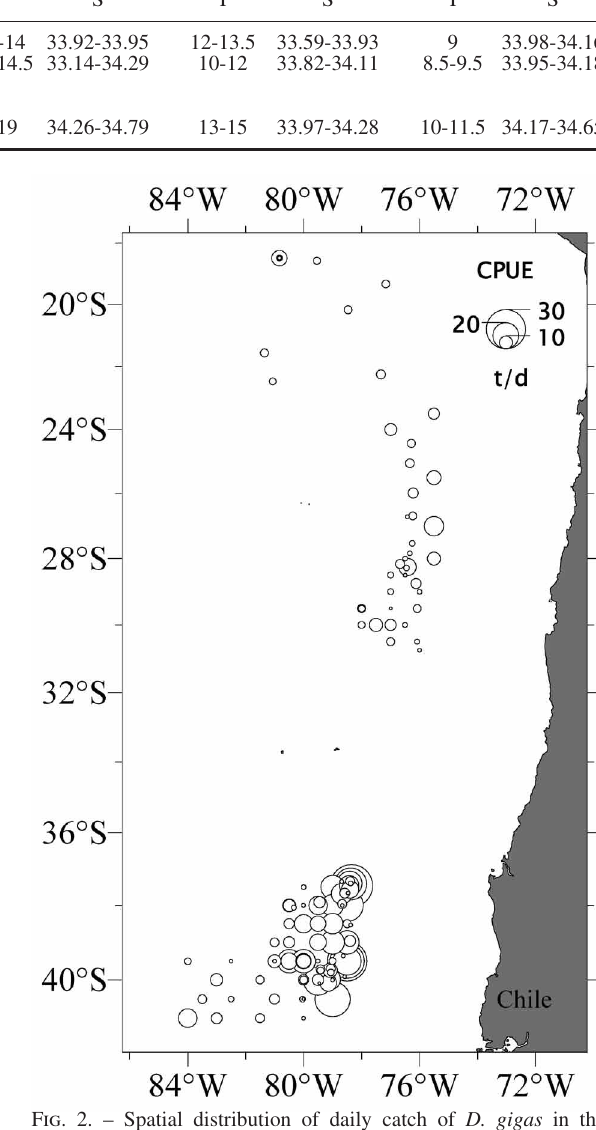
Table 3. – Temperature (T) and salinity (S) of different water depths in the fishing grounds of Dosidicus gigas off Chile. Areas